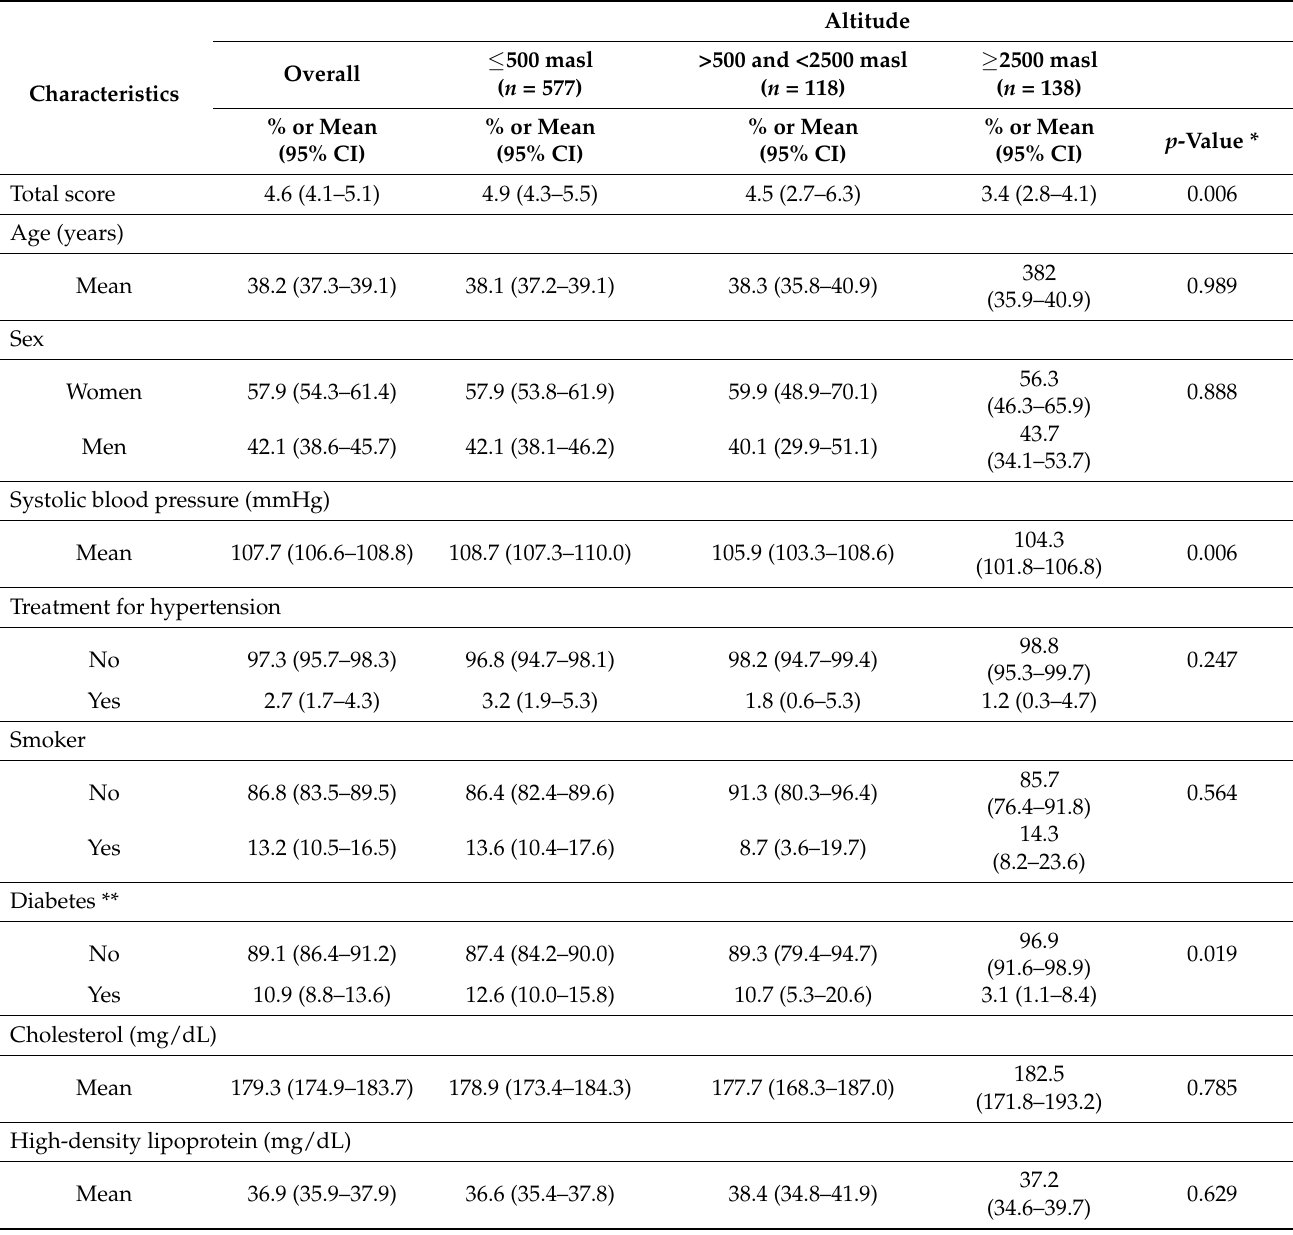
Table 2. Characteristics of the participants according to the Framingham criteria and altitude levels.